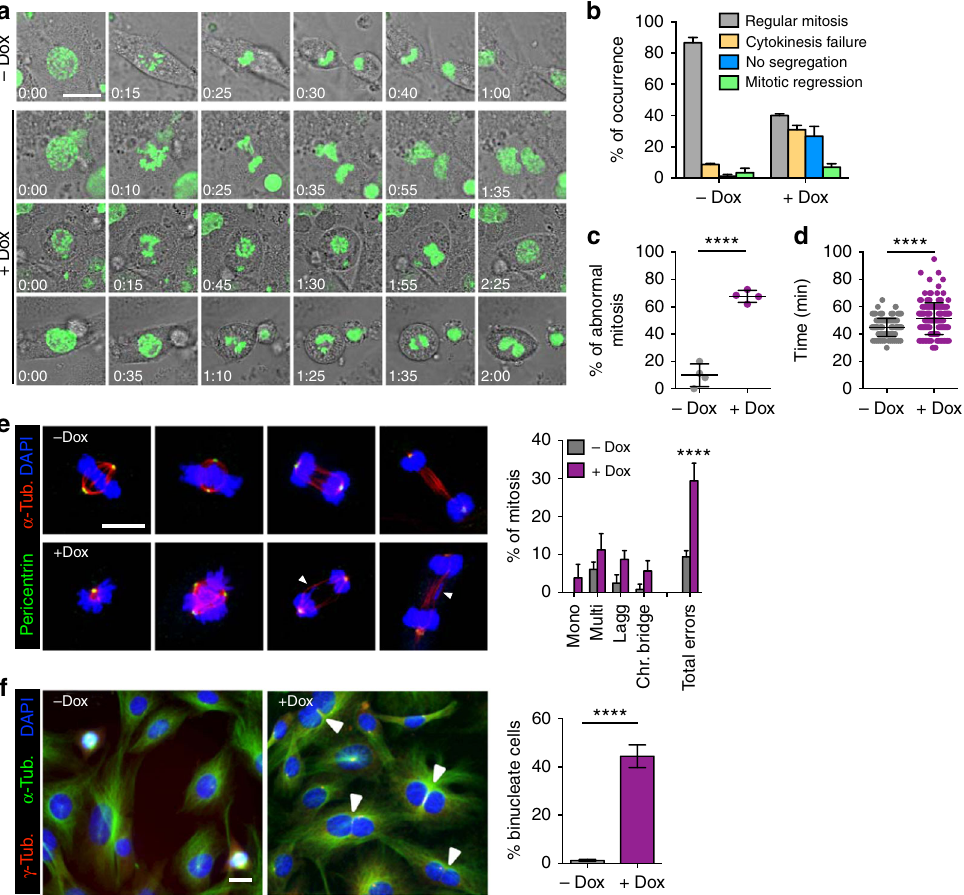
Fig. 3 Mitotic defects in Plk1-overexpressing MEFs. a Time-lapse microscopy of Plk1 MEFs untreated (upper panel) and after 8 h on Dox (lower panels), indicating mitotic cells; H2B-GFP (green), classi fi ed based on the three major phenotypes resulting in a tetraploid progeny in the case of Plk1 overexpression. Scale bar 20 μ m. b Percentage of occurrence of each major phenotype in – Dox ( n = 141) and + Dox ( n = 164) MEFs. c Percentage of mitotic errors per MEF ( – Dox: 141 cells; + Dox: 164 cells); points represent individual MEF line. d Duration of mitosis in the MEF cultures ( – Dox: 141 cells; + Dox: 164 cells). In c , d , **** p < 0.0001, Student ’ s t -test. e Immuno fl uorescence against α -tubulin and pericentrin in primary MEFs after 24 h on Dox followed by quanti fi cation of each mitotic phase and percentage of mitotic aberrancies ( – Dox: n = 149 mitotic cells; + Dox: n = 166 mitotic cells). **** p < 0.0001; two-way ANOVA. Scale bar, 10 μ m. f Immuno fl uorescence against α -tubulin and γ -tubulin in ( + /Plk1)(rtTA/rtTA) MEFs untreated ( – Dox) or treated with Dox for 48 h ( + Dox). Binucleated cells (arrowheads) from the total population (>100 cells from at least four random microscope fi elds